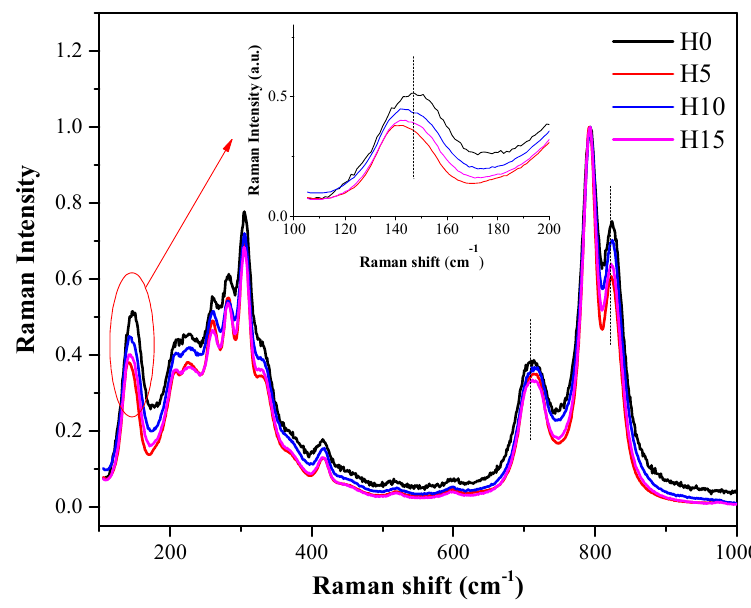
Figure 3. Raman spectra of Bi 2 WO 6 samples prepared using different HNO 3 concentrations.